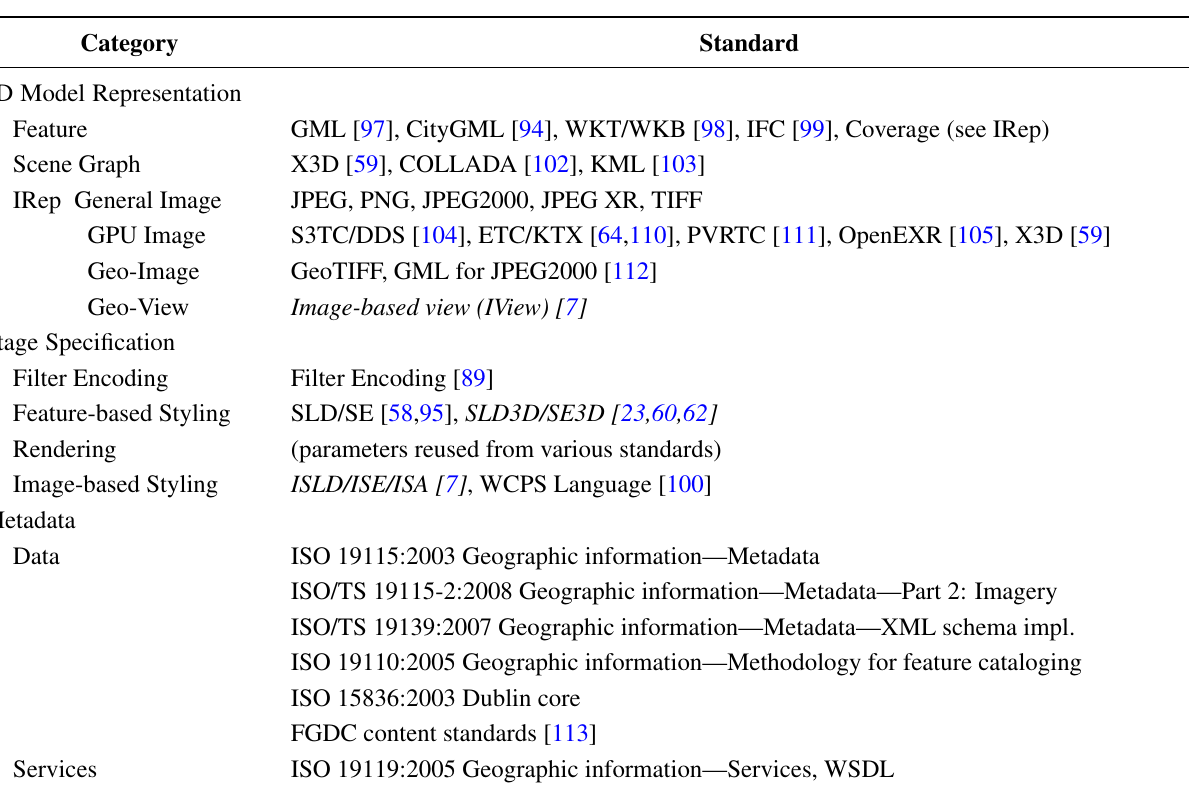
Table 3. Overview of a selection of relevant standards (regular font type) and standardization proposals (italic font type) for data models and